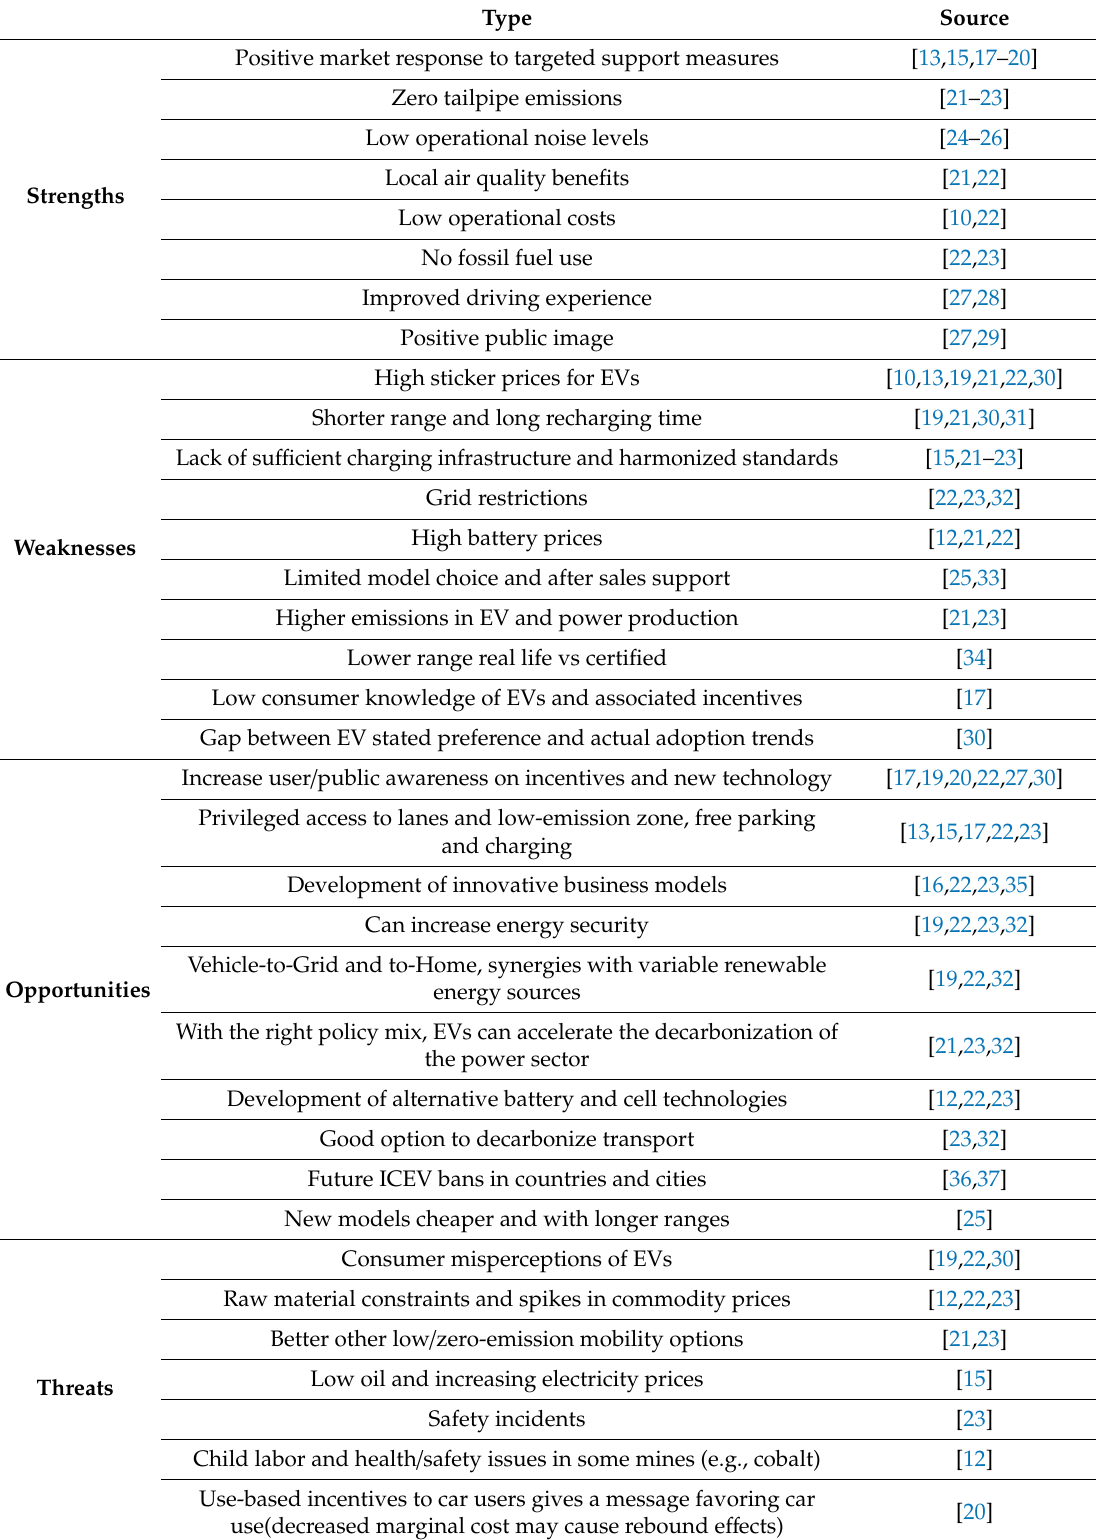
Table 1. Strengths, weaknesses, opportunities and threats related to EVs found in the